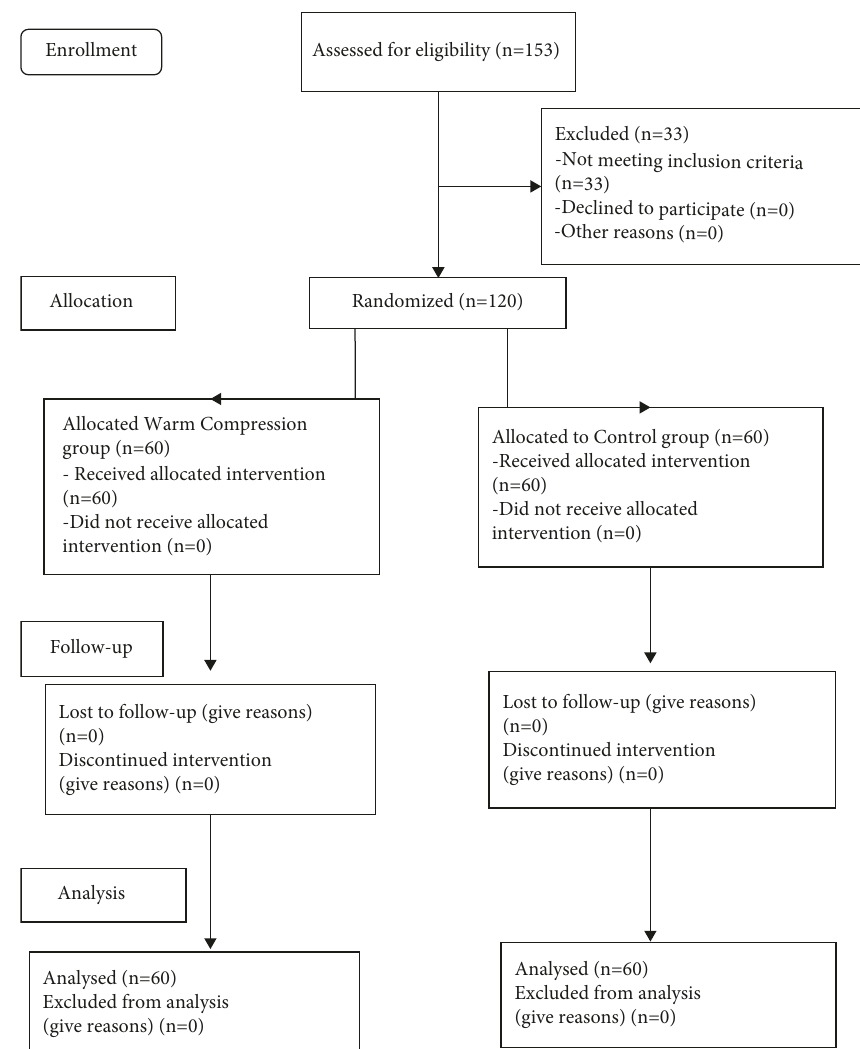
Figure 1: CONSORT flow diagram of the